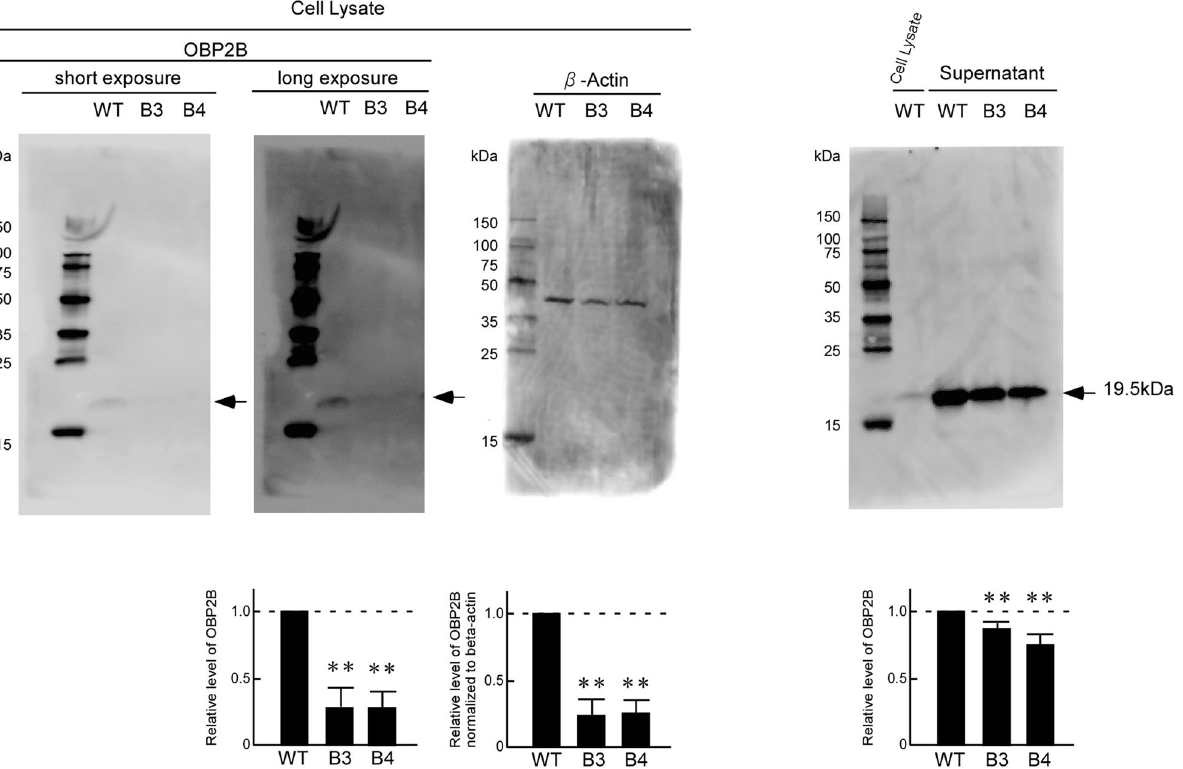
Figure 3. Quantitative decrease of OBP2B protein in the mutant clones B3 and B4 relative to that in the wild- type KATOIII cells. The amount of OBP2B or β-actin protein was evaluated by Western blotting using the cell lysate and supernatant prepared from the wild-type KATOIII cells and its derived mutant clones B3 and B4, followed by densitometry measurements. The representative blots are shown in the upper panels. The two panels on the left side show the blots of OBP2B obtained using a cell lysate after short or long exposure. The molecular weight of each protein was estimated using ECL DualVue Western blotting markers (cytiva). The amount of protein applied to each lane was 30 μg for the cell lysate or 20 μg for the supernatant. The left and right lower panels indicate the relative amounts of OBP2B protein in the cell lysate and supernatant, respectively, obtained from the mutant cells when that of the wild-type cells was assigned an arbitrary value of 1.0. The middle lower panel indicates the level of OBP2B normalized to the amount of β-actin in cell lysates in the mutant cells, relative to that for wild-type cells which was assigned an arbitrary value of 1.0. The relative level of OBP2B represents the mean from more than three independent experiments. The significance of the decrease was determined by Student’s t test at a significance level of p < 0.01